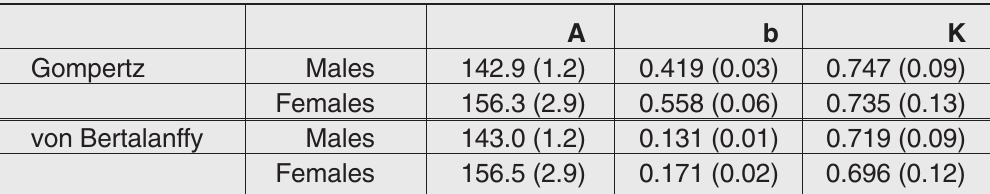
Table 1 : Parameter estimates for the Gompertz and von Bertalanffy growth curves from cross-sectional length-at-age data for male (n = 59) and female (n = 33) harbour porpoises from Eastern Newfoundland. Standard errors are in parentheses. A = asymptotic length (cm), b = fitted constant (no units), k = growth rate constant (yr 1 ).